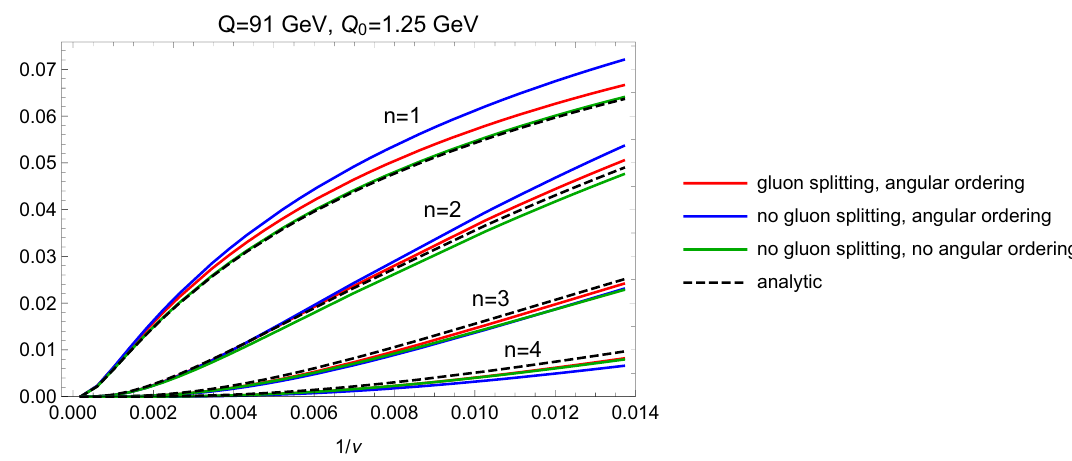
Figure 8. Laplace space parton level thrust distribution over 1 =(cid:23) in the peak region for Q = 91 GeV and Q 0 = 1 : 25 GeV shown for the (cid:12)nal state parton multiplicities n = 1 ; 2 ; 3 ; 4. Displayed are the analytic results (dashed black curves) and simulation results with gluon splitting and angular ordering both turned on (red curves), with gluon splitting turned o(cid:11), but angular ordering turned on (blue curves) and with gluon splitting and angular ordering both turned o(cid:11) (green